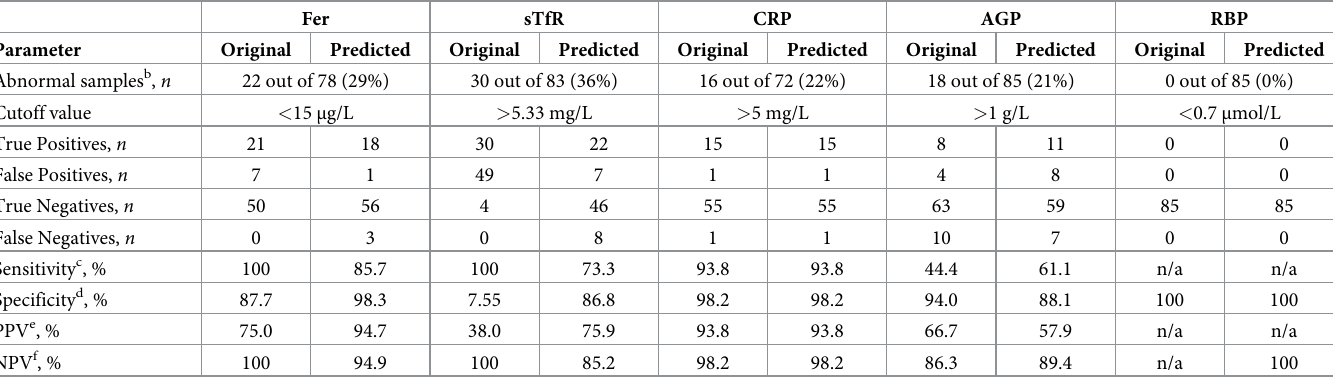
Table 3. Diagnostic performance of the Q-Plex assay for serum samples a .